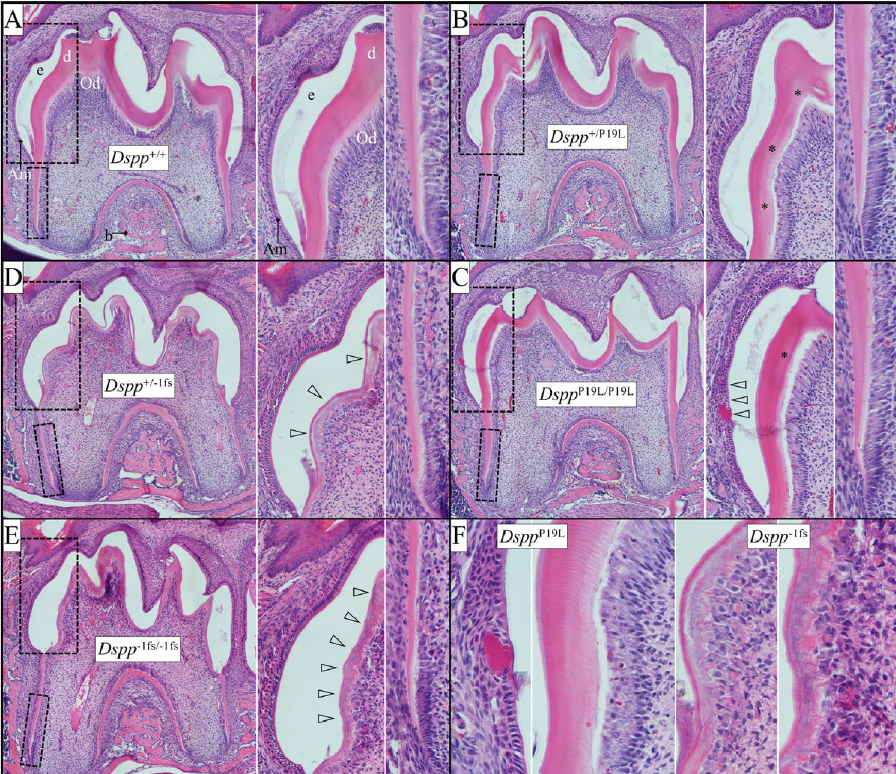
Figure 5. H&E staining of D14 Mandibular First Molars. ( A–E ) Longitudinal sections of first molars as they are about to erupt into the oral cavity are shown from Dspp +/+ , Dspp +/P19L , Dspp P19L/P19L , Dspp +/−1fs and Dspp −1fs/−1fs mice, with boxes showing the positions of higher magnification images on the right. Dspp +/P19L and Dspp P19L/ P19L molars show polarized columnar odontoblasts that form dentin with dentinal tubules, but the dentin stains unevenly (asterisks). Ameloblasts sometimes show patches of dysplasia associated with densely stained material (leftward pointing arrowheads). Odontoblasts in Dspp +/−1fs and Dspp −1fs/−1fs molars are dysplastic and